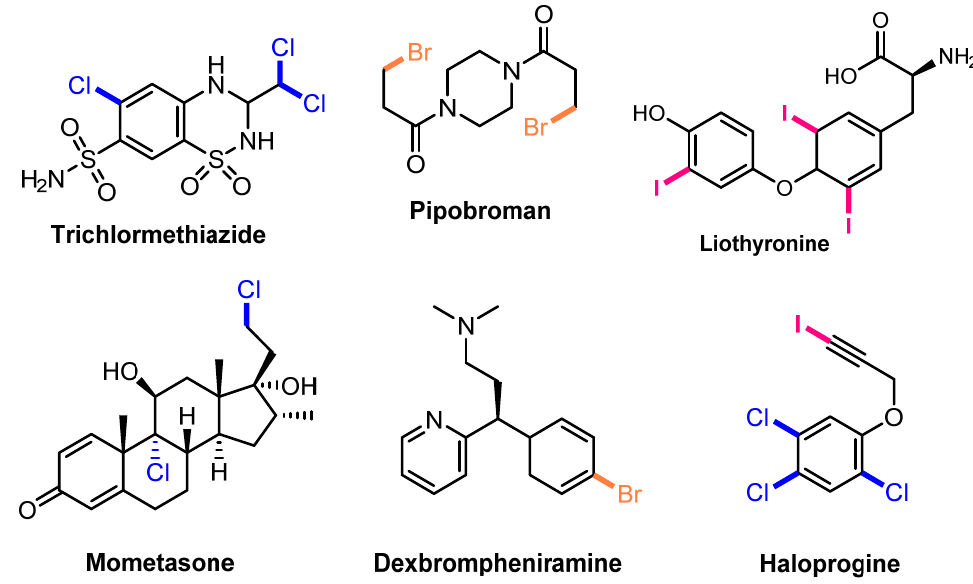
Figure 1. Several halogenated compounds in pharmaceuticals. Several classic or modified halogen sources including N-bromo-